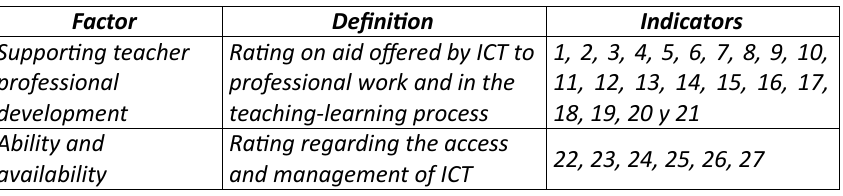
Table 1. Specifications of